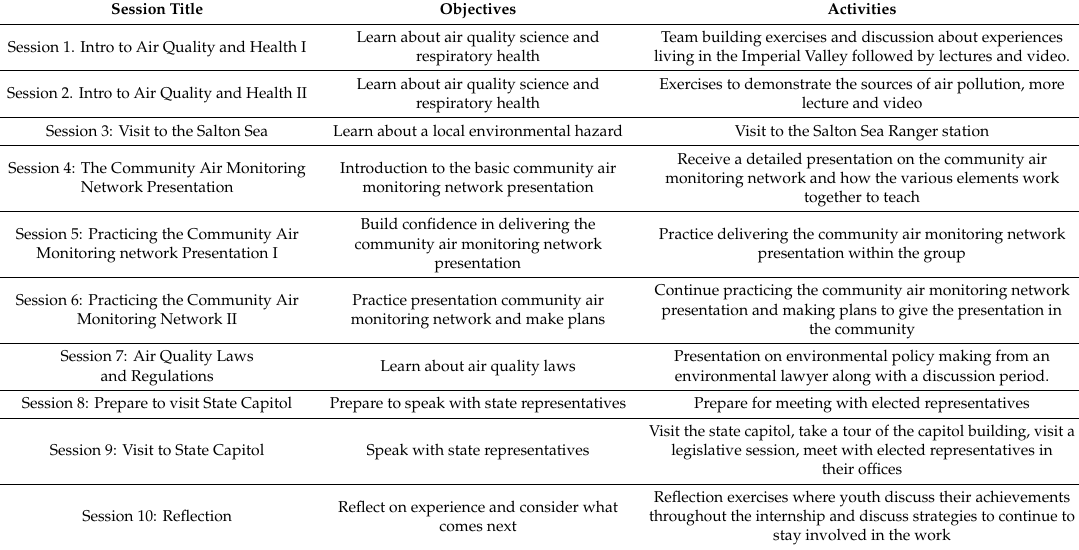
Table 1. Youth environmental health internship session titles, objectives, and